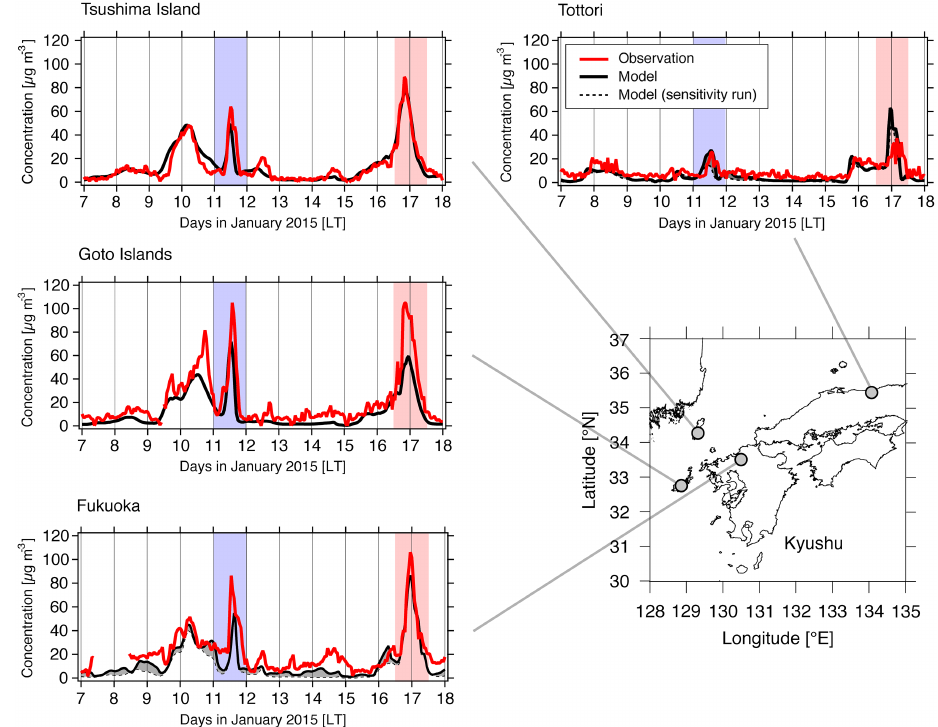
Figure 1. The temporal variation in PM 2 . 5 over Japan at Fukuoka, the Goto Islands, Tsushima Island, and Tottori from 7–17 January 2015. The blue and red shading shows the episodes focused on in this study. The red lines indicate the observations. The black lines indicate the base case simulation, and the dotted black lines indicate the sensitivity simulation in which the anthropogenic emissions from Japan were switched off; the differences between these results, shown in gray, represent local